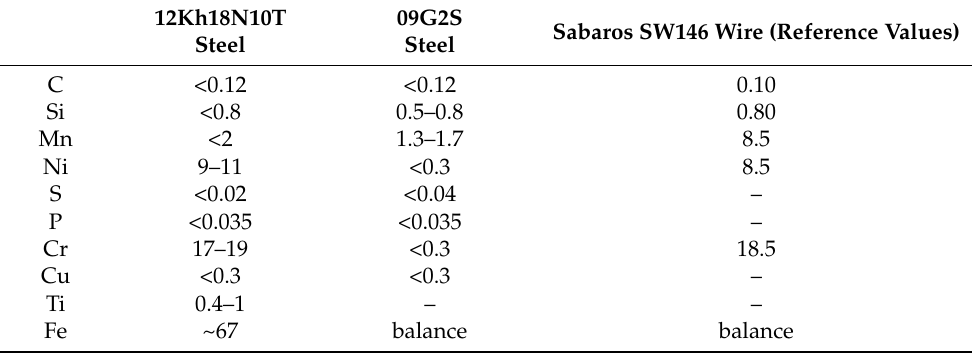
Table 1. Chemical composition of welded steels and a filler wire, wt %.